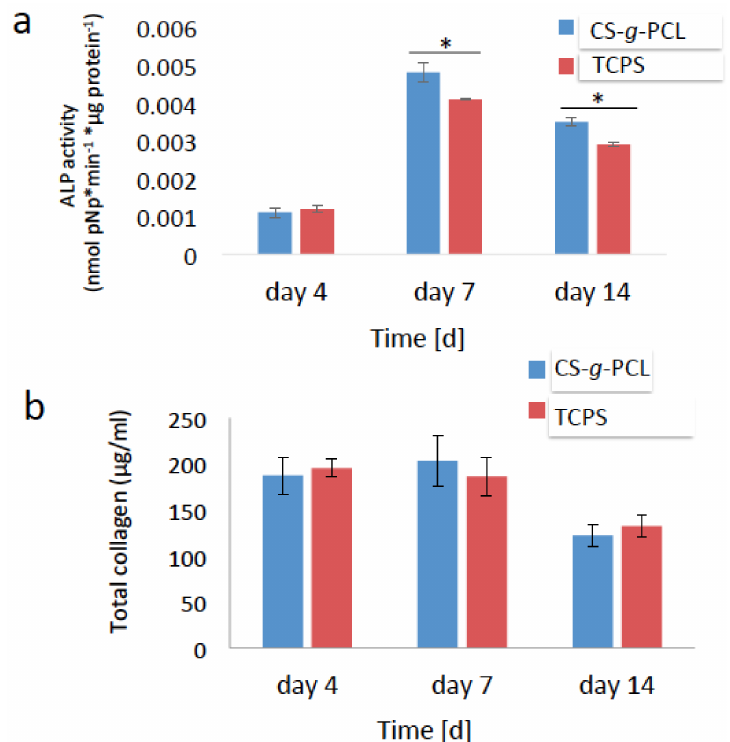
Figure 6. Early markers of osteogenesis: ( a ) Alkaline phosphatase (ALP) activity of the MC3T3-E1 cells cultured on the CS- g -PCL surface and TCPS for 4, 7 and 14 days. The ALP activity of the cells cultured on the CS- g -PCL was significantly increased compared to TCPS after 7 and 14 days; ( b ) Levels of collagen in the supernatants of the MC3T3-E1 cells cultured on the CS- g -PCL surface and on TCPS for 4, 7 and 14 days. The graft copolymer enhanced the production of collagen on day 7 compared to the control TCPS. Error bars represent the average of triplicates ± SEM of two independent experiments ( n =